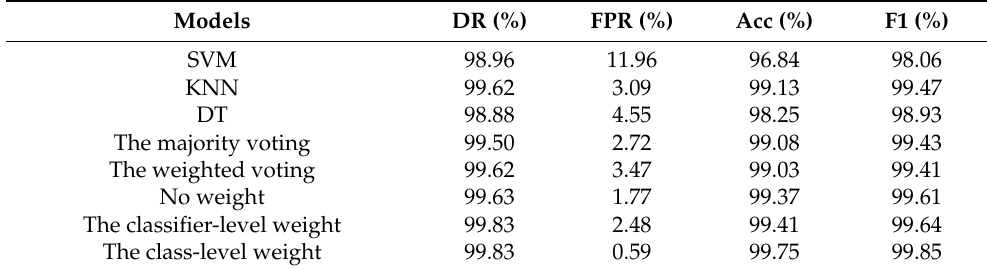
Table 10. Performance comparisons of the base learners and different voting ensemble methods with feature selection on the CICIDS2017